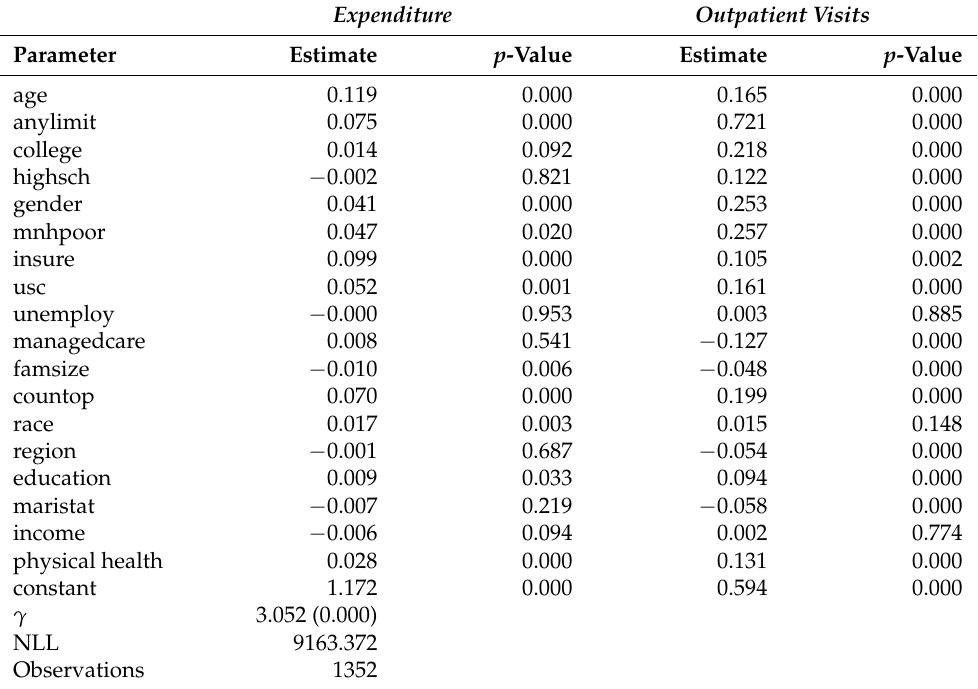
Table 4. Parameter estimates, p -values and the log-likelihood (NLL) for the model with covariates. Expenditure Outpatient Visits